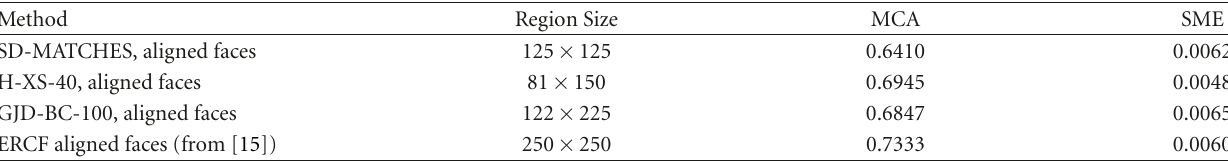
Table 4: Correct classification rates of the best methods (LFW database, restricted setting). MCA: Mean Classification Accuracy. SME: Standard Error of the Mean.